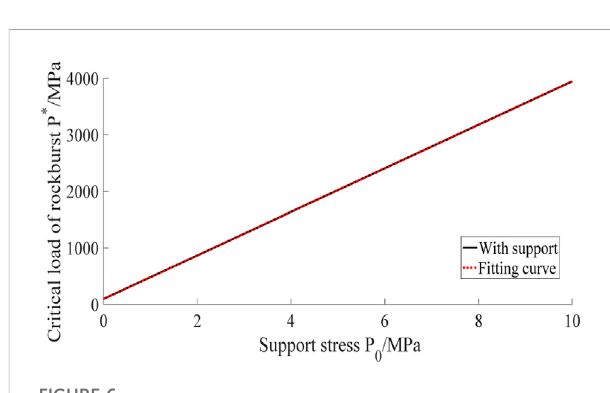
FIGURE 6 Support stress – critical load